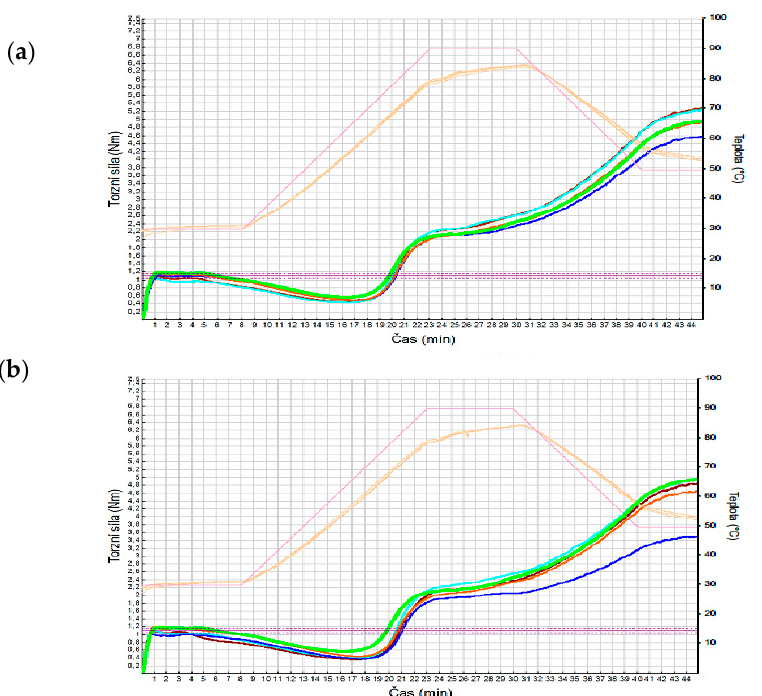
Figure 3. Curves recorded with the Mixolab. ( a ) recorded torque profile in the control sample and sam- ples with an addition of legume flours at an amount of 5%; ( b ) recorded torque profile in the control sample and samples with an addition of legume flours at an amount of 15%; Green—WF(50) + RF(50); Turquoise—addition of BBF; Brown—addition of RLF; Ochre—addition of ChF; Blue—addition of